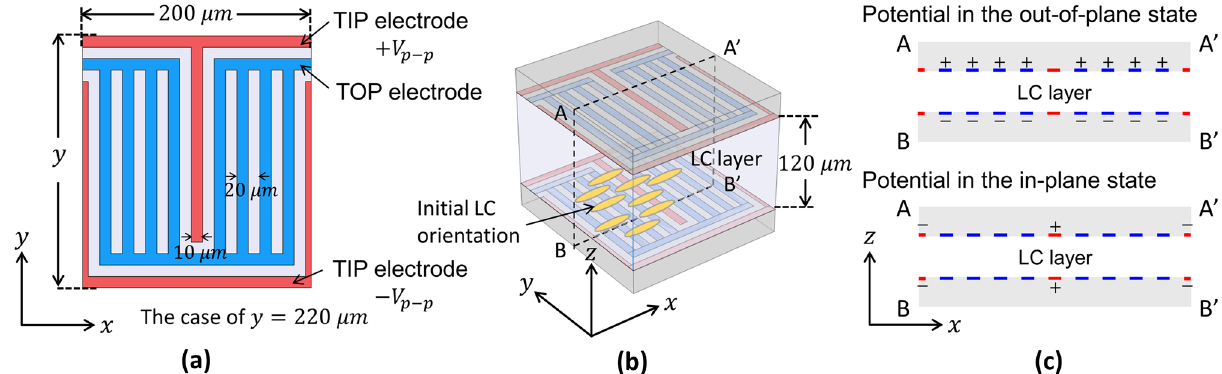
Figure 1. Schematics showing the geometry of the unit cell used in our calculations. ( a ) Electrode structures on each substrate. ( b ) Unit cell structure. ( c ) Potential applied to the electrodes along cross-section AA ′ BB ′ illustrated in ( b